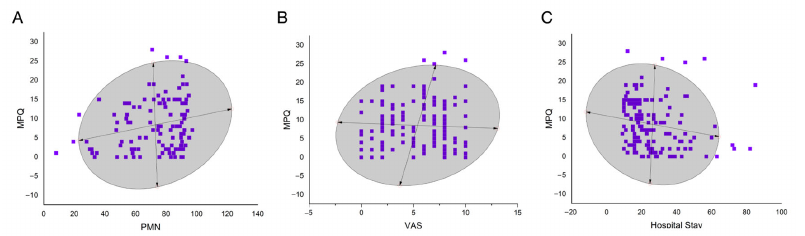
Figure 3. The 95% confidence ellipses for the correlation analysis. ( A ) MPQ total score and PMN%; ( B ) MPQ total score and preoperative VAS score; ( C ) MPQ total score and hospital stay.